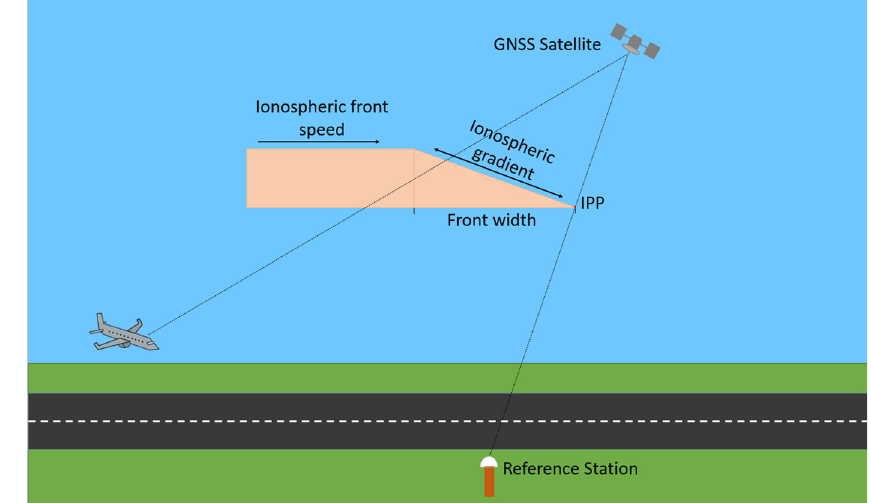
Figure 2: Representation of variation of the ionospheric gradient for GBAS.